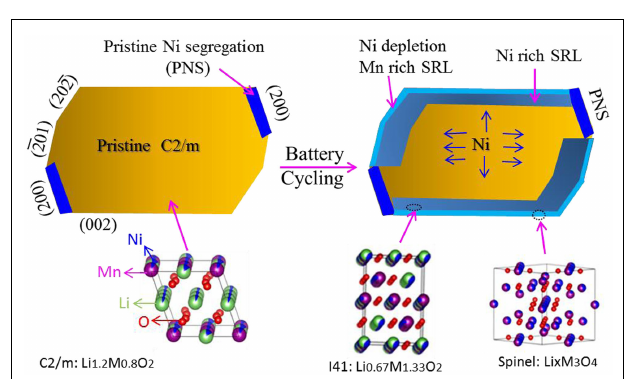
FIGURE 9 | Schematic diagram showing cycling-induced surface layer evolution . At the left side, the pristine particle has a C2/m structure, and PNS layers are located at (200) surface planes. After cycling, because of Ni 2 + migration from the bulk region to the surface, Mn 2 + surface aggregation and Li + depletion in surface layer, an SRL is developed on the particle surface, except for the PNS. The surface layer structure transforms from the original C2/m into I4 1 and finally develops a spinel structure because of progressive TM enrichment and Li depletion. The I41 structure is the main phase in the SRL (Yan et al., 2015). Reprinted with permission from Yan et al. (2015). Copyright 2015 American Chemical Society.